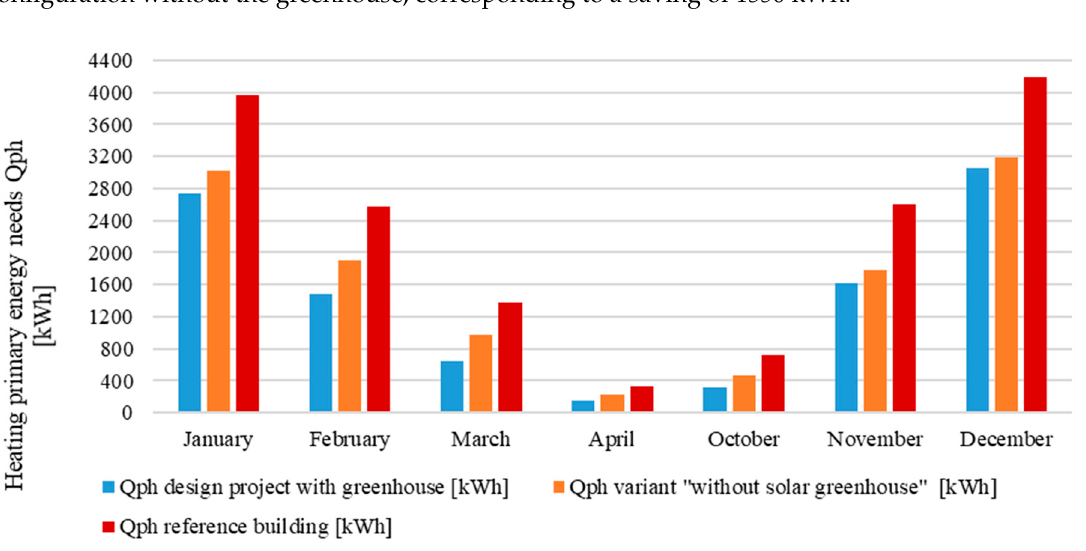
Figure 12. Comparison between the heating primary energy needs of the design building equipped with a solar greenhouse with the variant “without solar greenhouse” and the reference building.